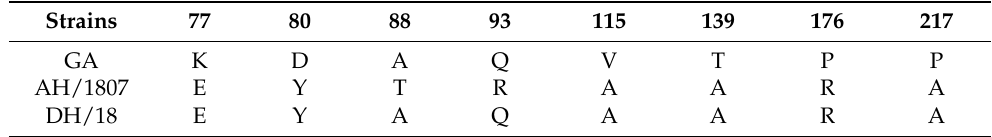
Table 4. Amino acid substitutions in meq oncoprotein of the two